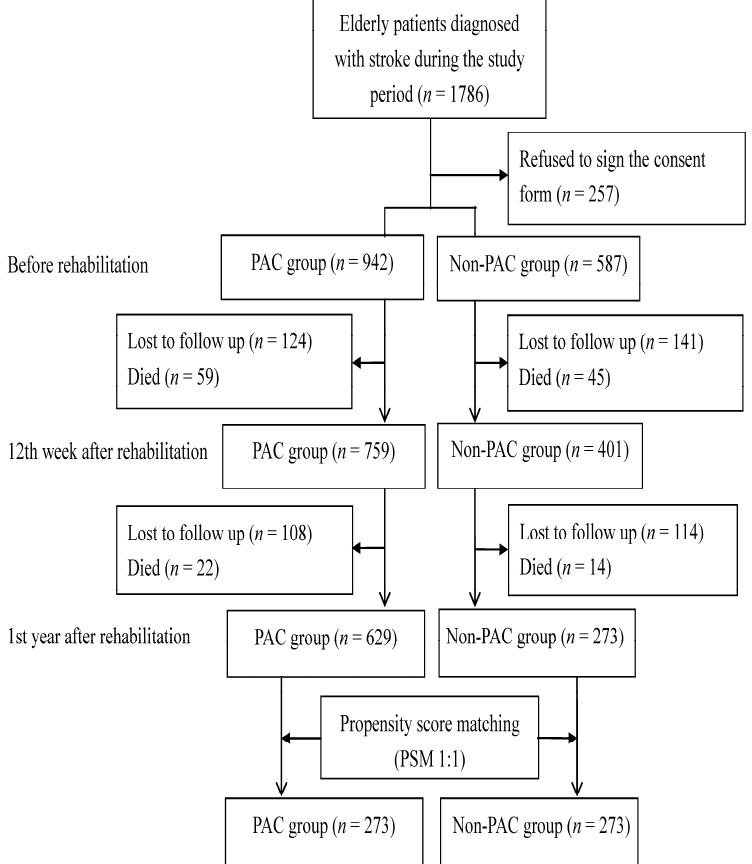
Figure 1. Flow chart showing population changes during the study, including patients who met initial exclusion criteria, those who later declined to participate and those who lost to follow-up.